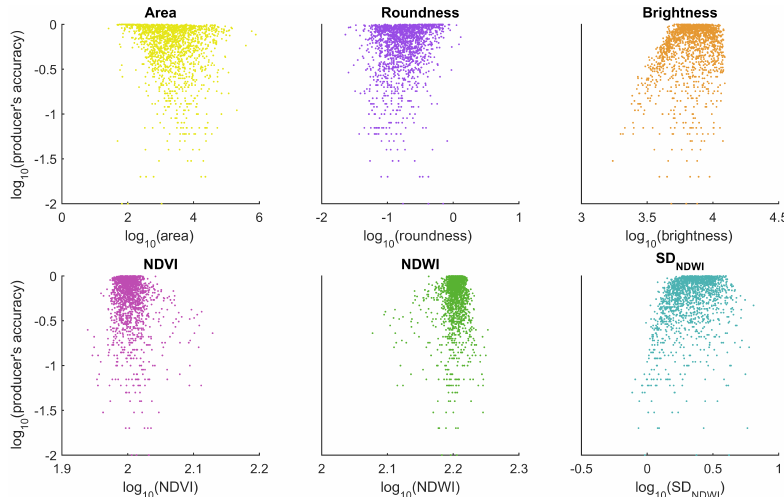
Figure 6. The role of avalanche area, roundness, brightness, normalised difference vegetation index (NDVI), normalised difference water index (NDWI), and standard deviation of normalised difference water index (SD NDWI ) in the estimated accuracy when detecting snow avalanches with our OBIA approach.